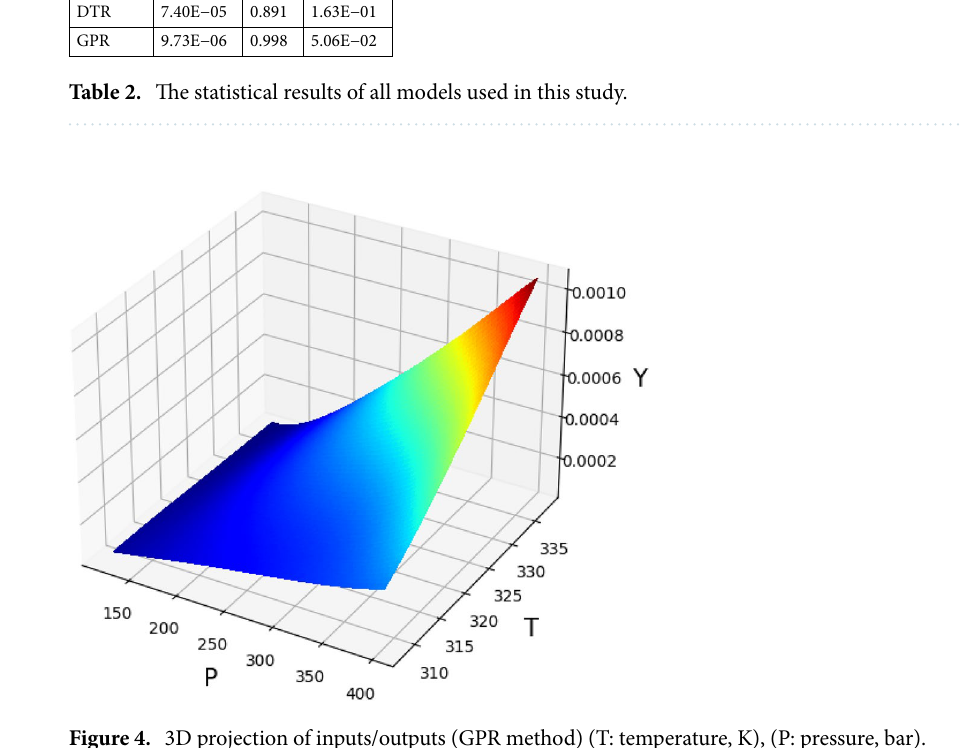
Figure 4. 3D projection of inputs/outputs (GPR method) (T: temperature, K), (P: pressure, bar).